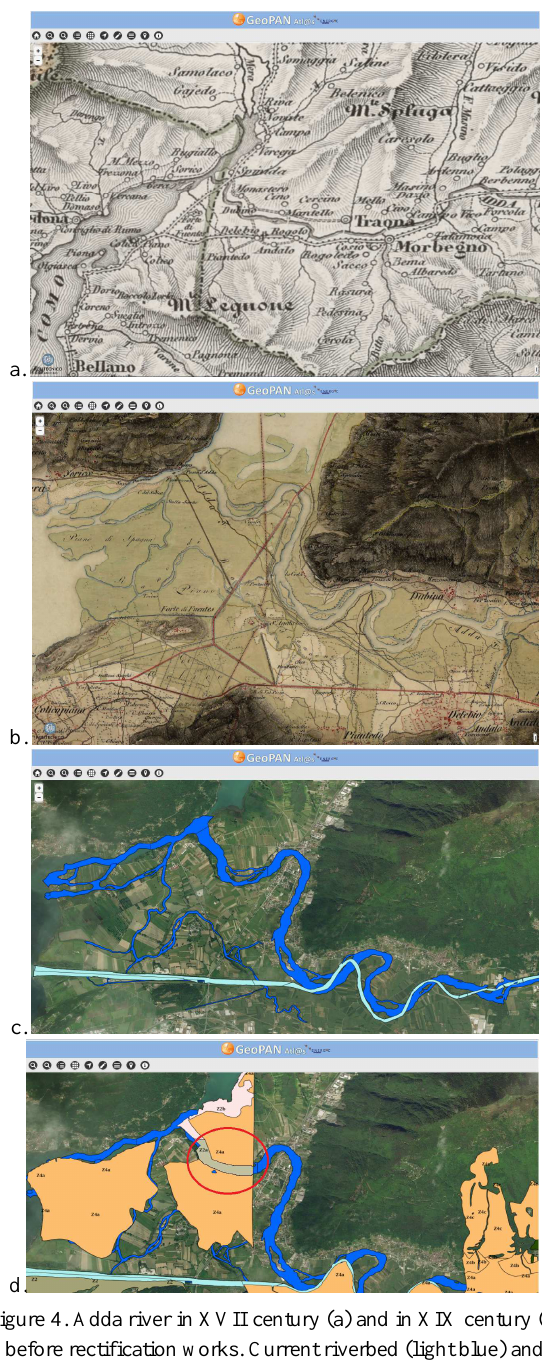
Figure 4. Adda river in XVII century (a) and in XIX century (b) before rectification works. Current riverbed (light blue) and former riverbed (dark blue) (c) shows good match with areas characterized by higher seismic risk (olive) as highlighted in the red area (d).